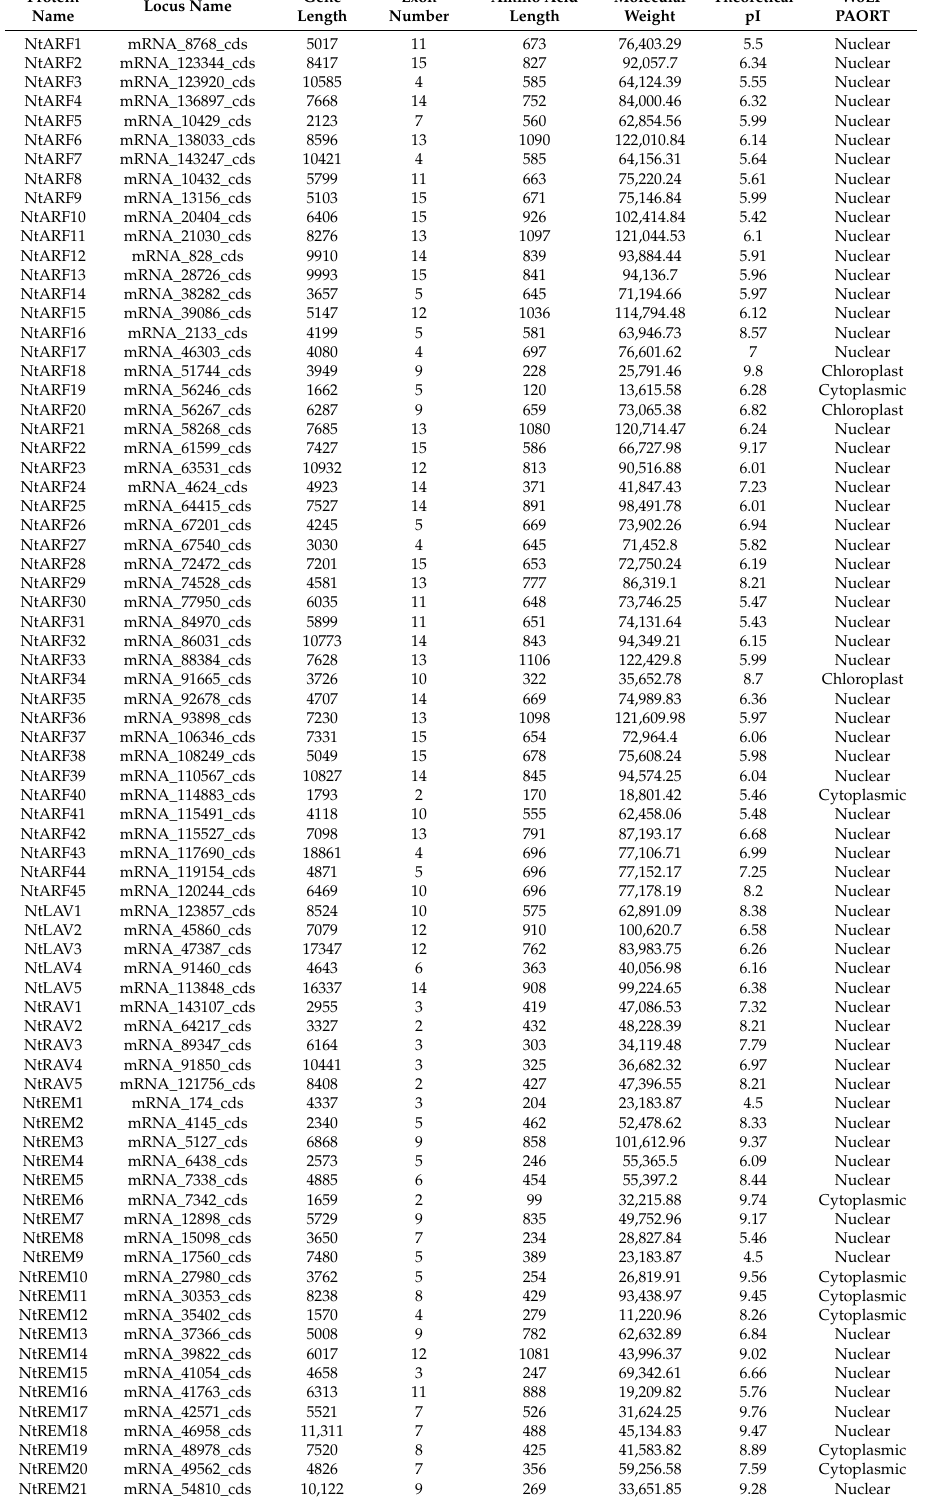
Table 1. Characteristic features of B3 transcription factor superfamily identified in